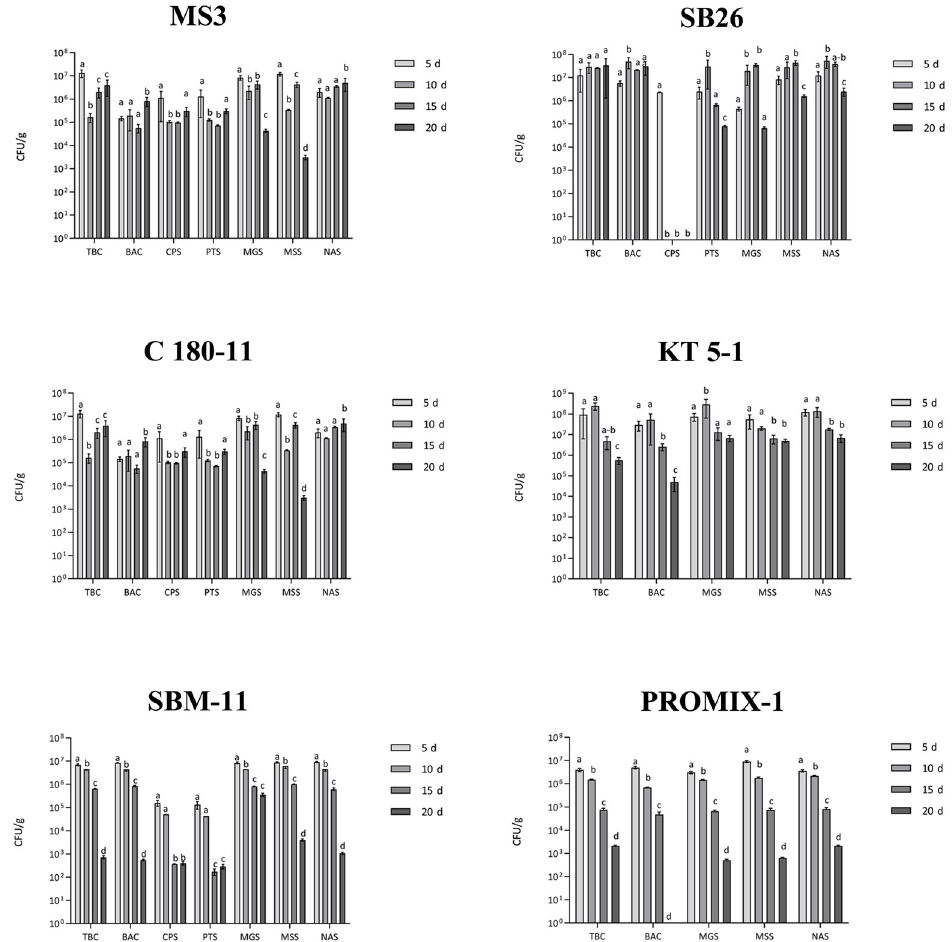
Figure 3. Evolution of microbial counts over 20 days of fermentation of Jellyfish-based food products (Jelly paste) inoculated with selected bacterial strains. SB26: Staphylococcus pasteuri ; MS3: Bacillus amyloliquefaciens ; C 180-11: Lactiplantibacillus plantarum ; KT 5-1: Leuconostoc mesenteroides . Commercial microbial starter preparations provided by Sacco srl, SBM-11: Lactobacillus sakei , Staphylococcus carnosus and S. xylosus ; PROMIX-1: S. xylosus . The initial inoculum of the four bacterial starter strains (C 180-11, KT-5-1, MS3, SB26) and of two commercial bacterial starter preparations (SBM-11, PROMIX-1, Sacco Srl, Cadorago, Italy) was about 10 8 CFU/g. Microbial parameters: TBC (total bacterial count, accounting for aerobic colony count), BAC ( Bacillus spp.), CPS (presumptive coagulase-positive staphylococci), PTS (presumptive total staphylococci), YDRBC (total yeast count), MDRBC (total mold count), MGS (MRS glucose seawater salts), MSS (MRS sucrose seawater salts), NAS (nutrient agar seawater salts). Media where microbial counts were equal to zero were not reported. For